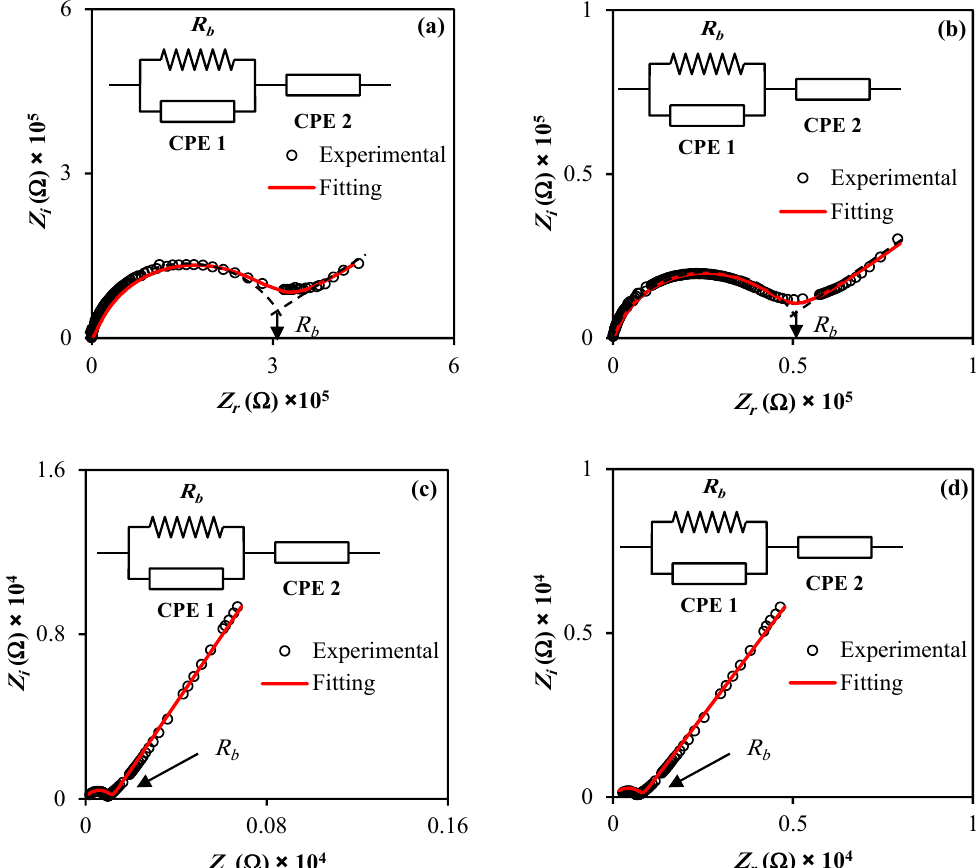
Figure 2. Impedance plots for ( a ) MCKI1, ( b ) MCKI2, ( c ) MCKI3, and ( d ) MCKI 4 electrolyte films. Table 1. The EEC fitting parameters for the systems fabricated